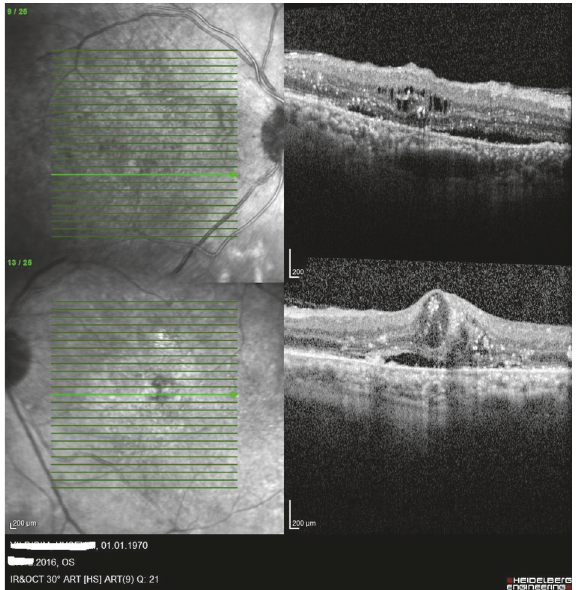
Figure 4: Serous retinal detachments levels were decreased (supe- rior image is right eye and inferior image is left eye).